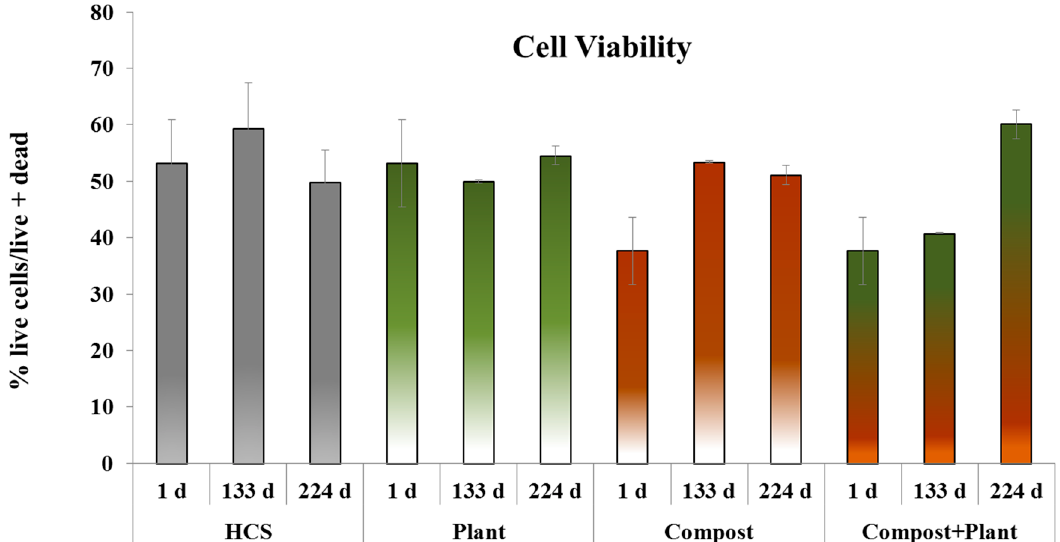
Figure 4. Cell viability (% live cells/live + dead) in the three sampling times (days 1, 133 and 224). HCS: